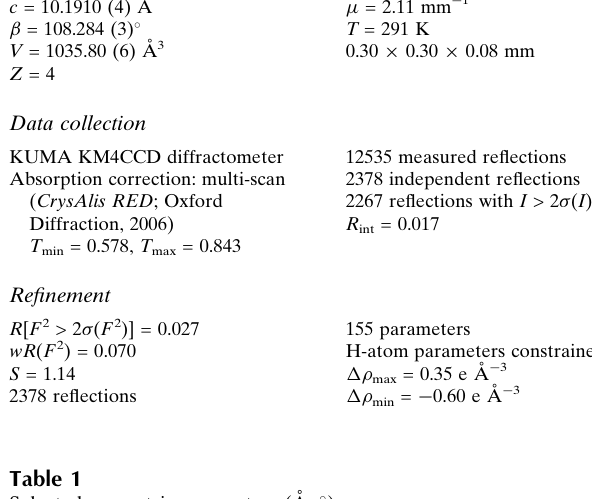
Selected geometric parameters (A˚ , (cid:1)